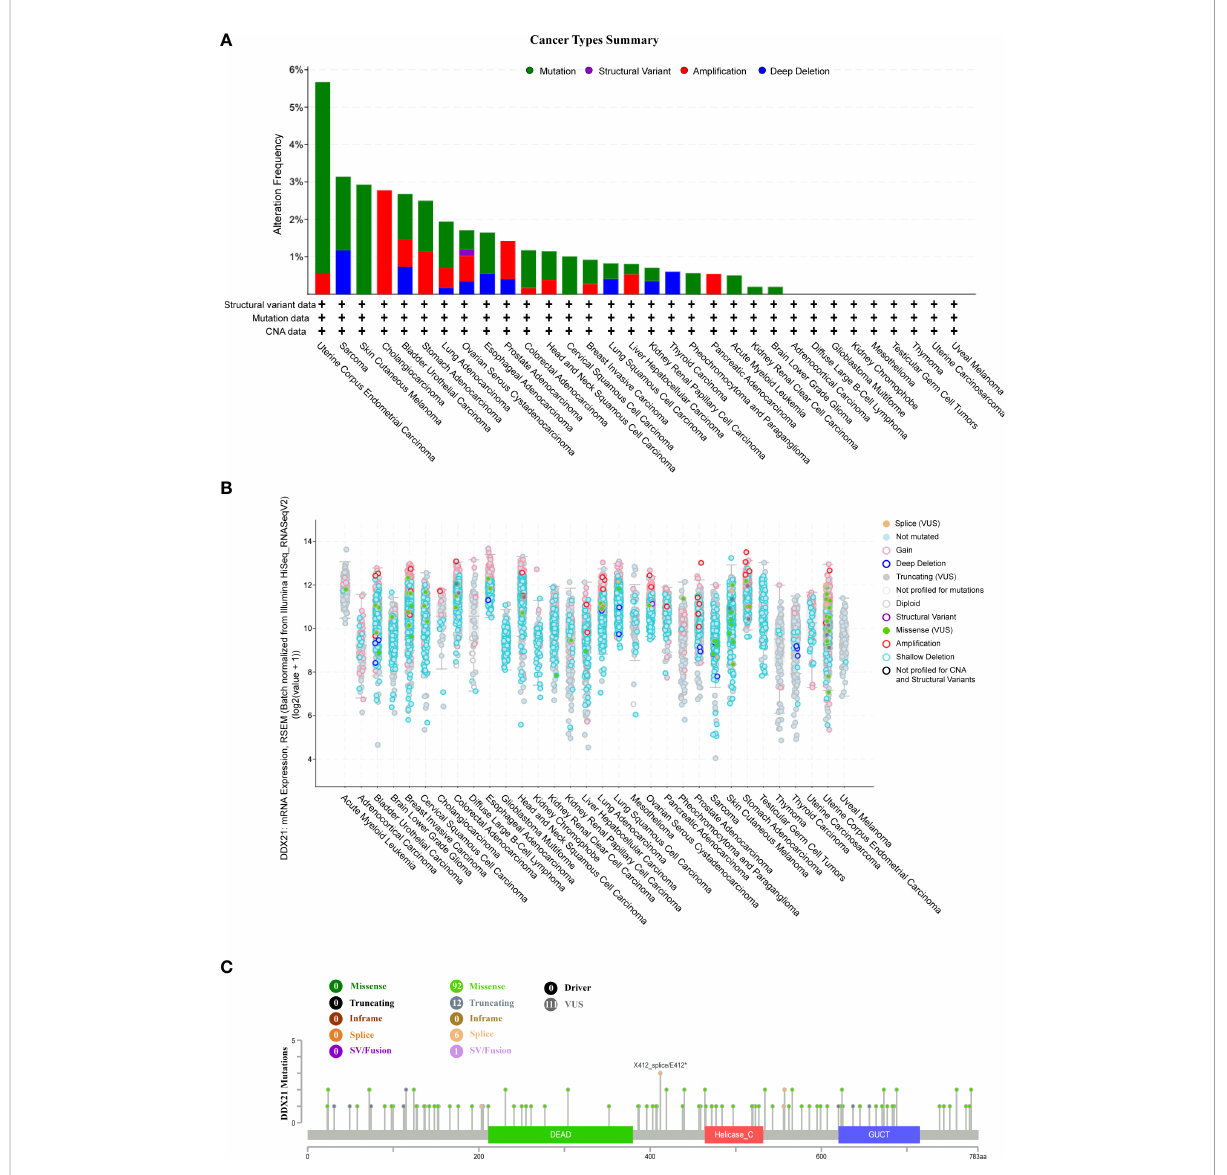
FIGURE 6 DDX21 mutation landscape. (A) DDX21 mutation frequency in multiple TCGA pan-cancer studies according to the cBioPortal database. (B) General mutation count of DDX21 in various TCGA cancer types according to the cBioPortal database. (C) Mutation diagram of DDX21 in different cancer types across protein